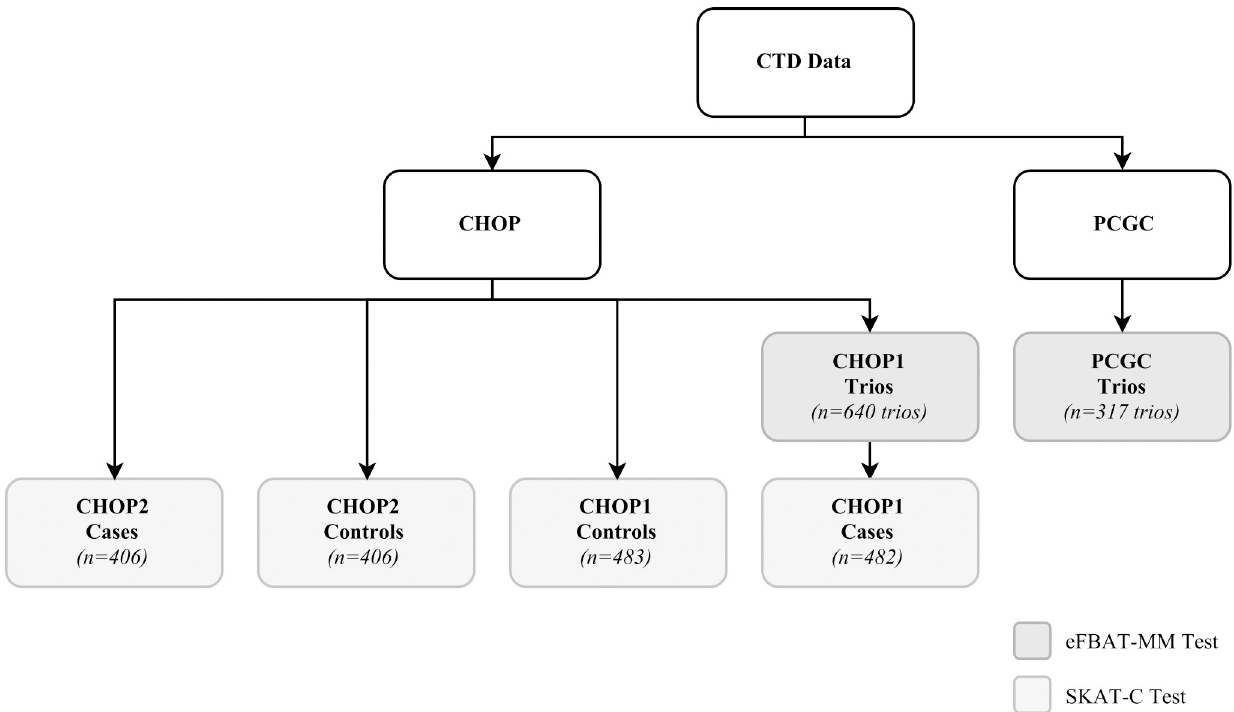
Fig 1. Summary of conotruncal heart defects data cohorts. The participants were recruited from the Children’s Hospital of Philadelphia (CHOP) and the Pediatric Cardiac Genomics Consortium (PCGC). CHOP-Trios and PCGC-Trios were analyzed using eFBAT-MM whereas SKAT-C was used to analyze the two case-control cohorts (CHOP-CC1 and CHOP-CC2). The cases in CHOP-CC1 are the Caucasian subset of cases in CHOP-Trios. One of 483 Caucasian cases was excluded during QC procedures prior to SKAT-C analysis.